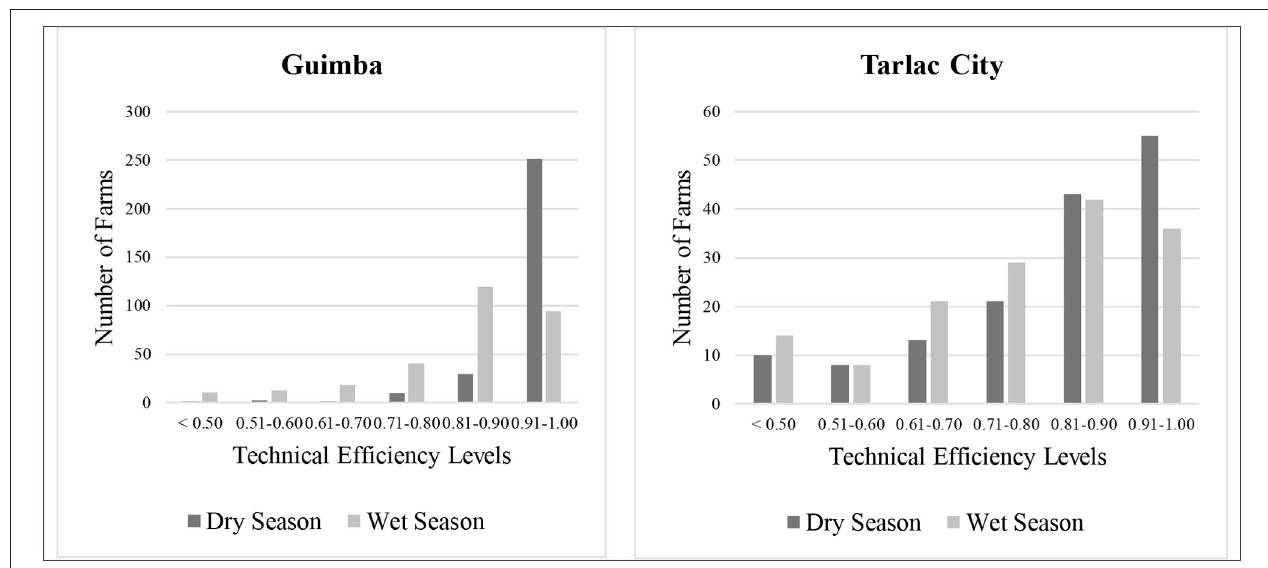
FIGURE 1 | Distribution of levels of technical efficiency of farms in Guimba and Tarlac during the dry and wet cropping